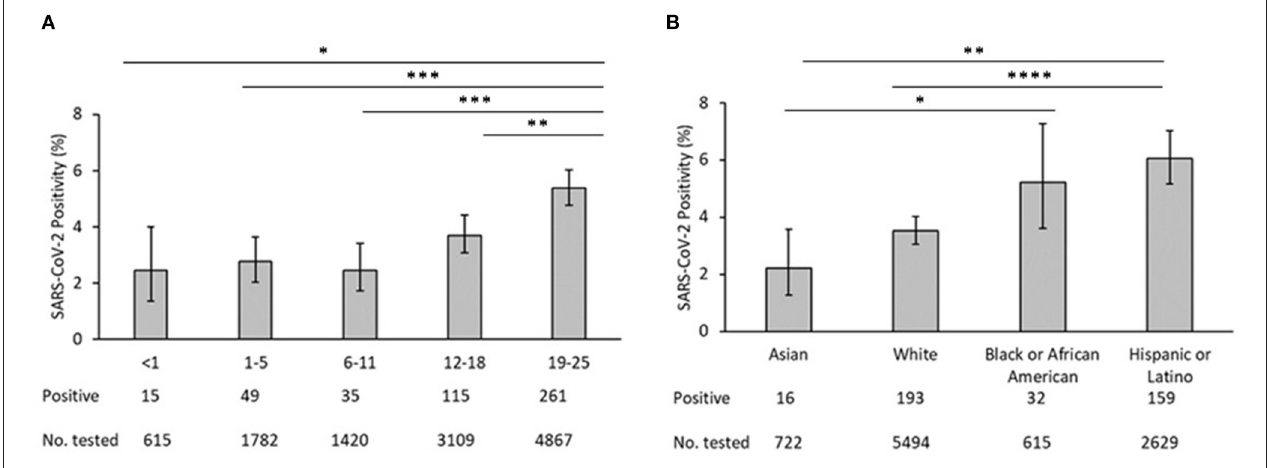
FIGURE 1 | (A) SARS-CoV-2 test positivity by age. (B) SARS-COV-2 test positivity by race/ethnicity. I n each panel, bars represent the mean proportion of positives + / − 95% confidence interval. * p < 0.05, ** p < 0.01, *** p < 0.001, **** p <